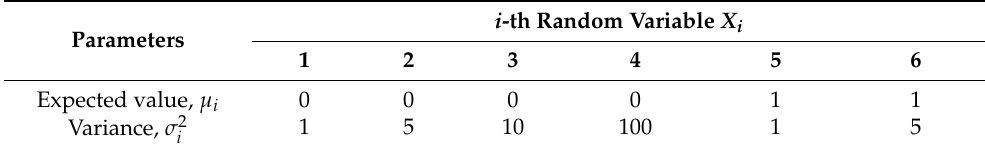
of the first six random variables X i . i